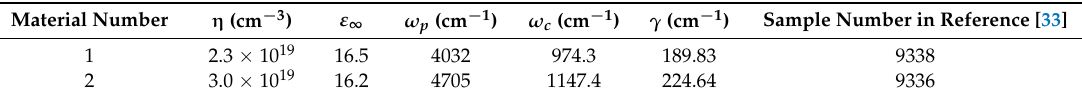
Table 2. Drude parameters for phosphorus-doped Ge derived, from [33] using RefFIT [42]. The thicknesses of the germanium films reported in [33] are of 2 µ m.